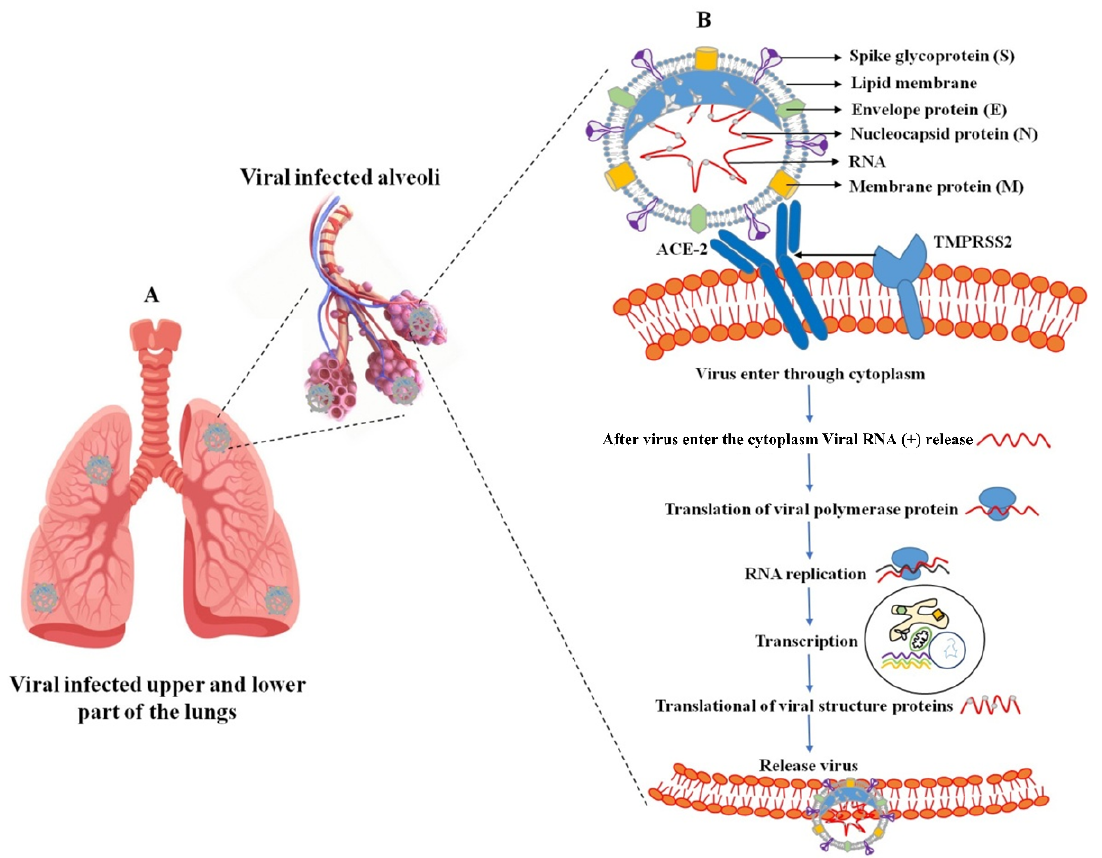
Figure 1. SARS-CoV-2 infection in the upper and lower part of the lungs ( A ); virus-infected host cell and virus propagation cycle ( B ). The SARS-CoV-2 virus consists of membrane proteins (M) in the lipid membrane along with envelope proteins (E) and spike glycoproteins linked to the envelope. RNA bound to the nucleocapsid protein exists inside the virus. External binding protein S can enter the lungs by binding to angiotensin-converting enzyme-2 (ACE-2) receptors present in human lung cells. In this case, the virus releases RNA together with genetic information and performs RNA replication to synthesize all components of the virus. Synthetic components are assembled and released out of lung